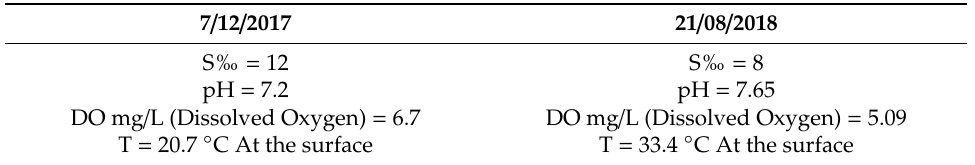
Table 1. Environmental factors in the Cahong lake measured in winter (December 2017) and summer August